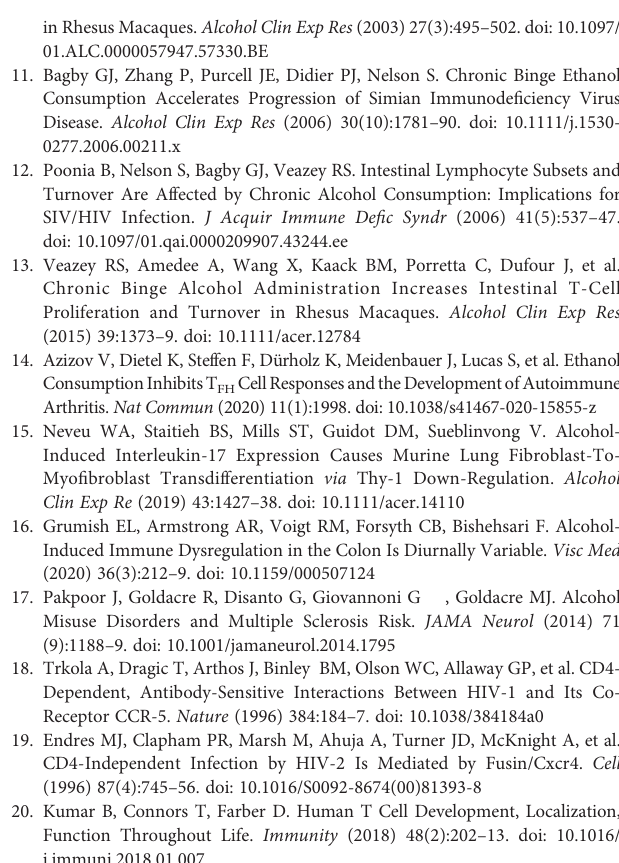
Supplementary Figure 1 | IL-12 promotes FOXP3 expression similar to TGF- beta + IL-2 in CD3/CD28 stimulated CD4 + T cells. Supplementary Figure 2 | Gating strategy used for assessment of master transcription factor expression in CD4 + T cells. Supplementary Figure 3 | Moderate enrichment of CD25+FOXP3+ and CD25- Tbet+ CD4 T cells by MACS sorting. (A) CD4+CD25+ T cells were enriched with FOXP3+ Cells. (B) CD4+CD25- T cells were enriched with Tbet+ Cells. Supplementary Figure 4 | Gating strategy used for assessment of 2-NBDG uptake in CD4 + T cells. Supplementary Figure 5 | Gating strategy used for assessment of Mitotracker Deep Red mitochondrial stain in CD4 + T cells. Supplementary Figure 6 | Bioenergetic Health Index (BHI) and Oxygen Consumption Rate (OCR)/Extracellular Acidi fi cation Rate (ECAR) of enriched Treg andTh1subsets. (A) Therewerenosigni fi cantdifferencesobservedinBHIbetween DIFF and DIFF + EtOH of enriched Treg or Th1 subsets. (B) There were no signi fi cant differences observed in OCR/ECAR between DIFF and DIFF + EtOH of enriched Treg of Th1 subsets. Paired T